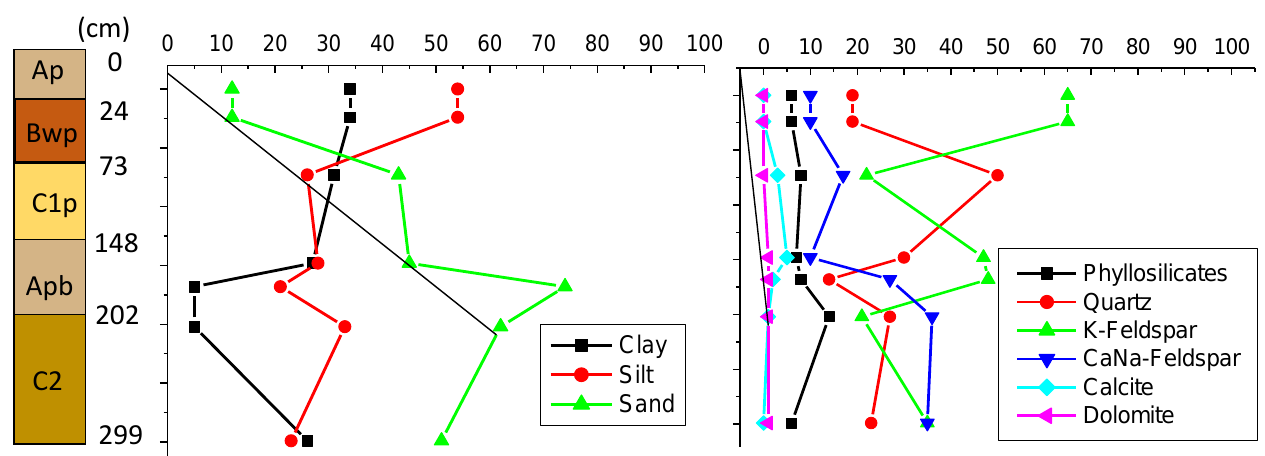
Figure 5. Texture and mineralogical composition of the studied soil profile.